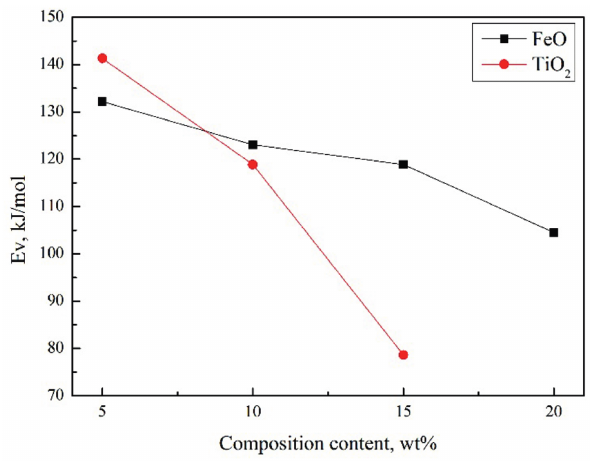
Figure 9: Effect of FeO and TiO 2 concentration on the apparent activation energy of viscous flow of slags in I